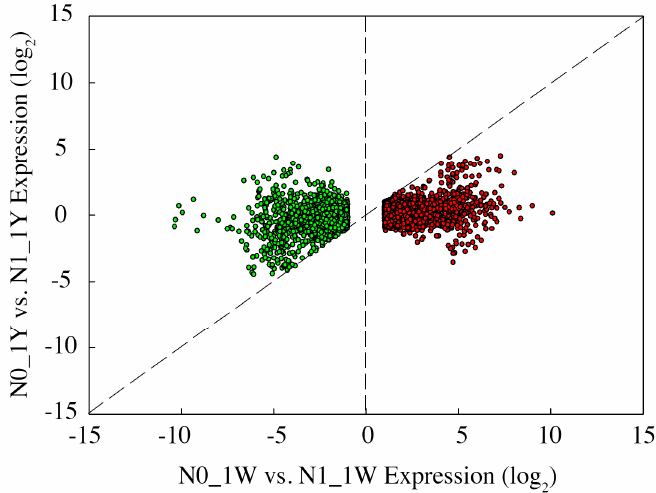
Figure 5. Scatter plot comparing the expression levels for the 4725 genes specifically expressed in the N0_1W vs. N1_1W comparison between N treatments in each wheat NIL. Each point represents an individual DEG, and the red and green colors of the graph represent the genes that are upregulated or downregulated.